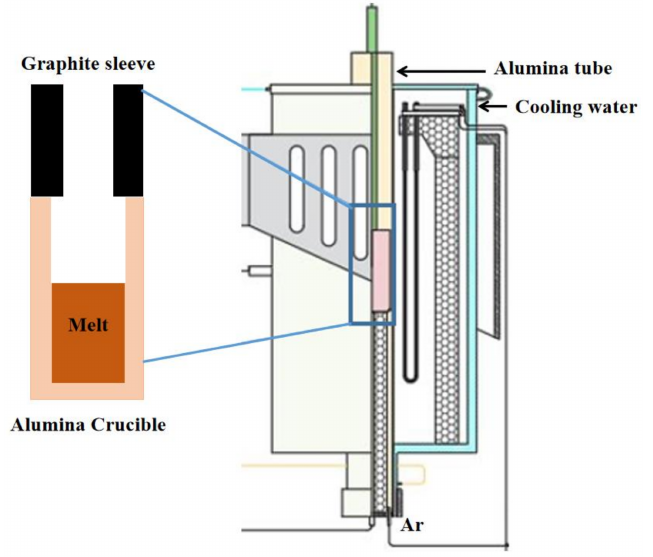
Figure 2. Experimental device.